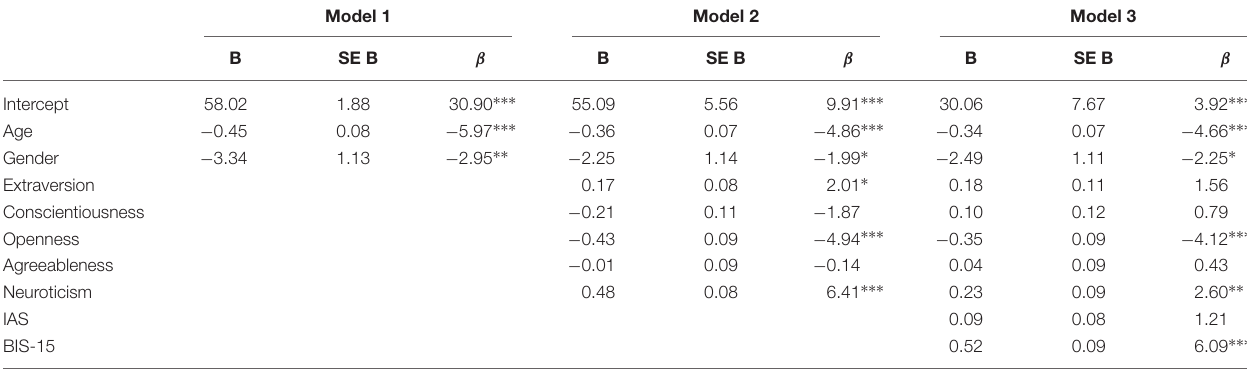
TABLE 7 | Summary of hierarchical regression analysis for variables predicting SPAI ( N =